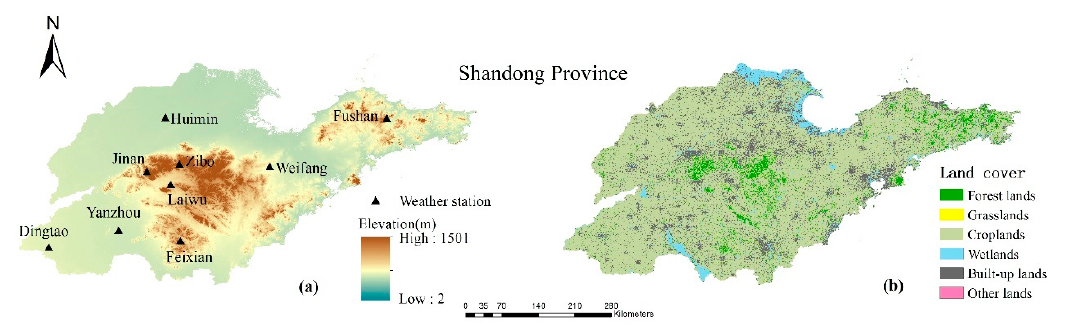
Figure 1. ( a ) Elevation map of the Shandong Province with weather station locations and ( b ) the land cover map of the Shandong Province in China.